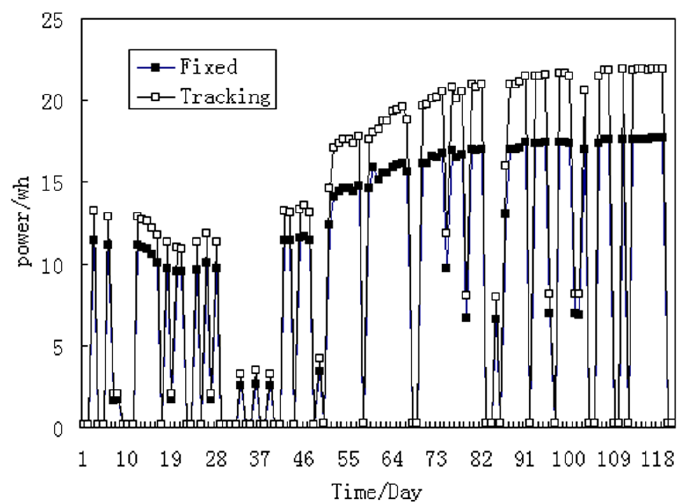
Figure 7. Power generated (Wh) over a four month period (December–March) by the Fixed and Tracking Solar Systems.